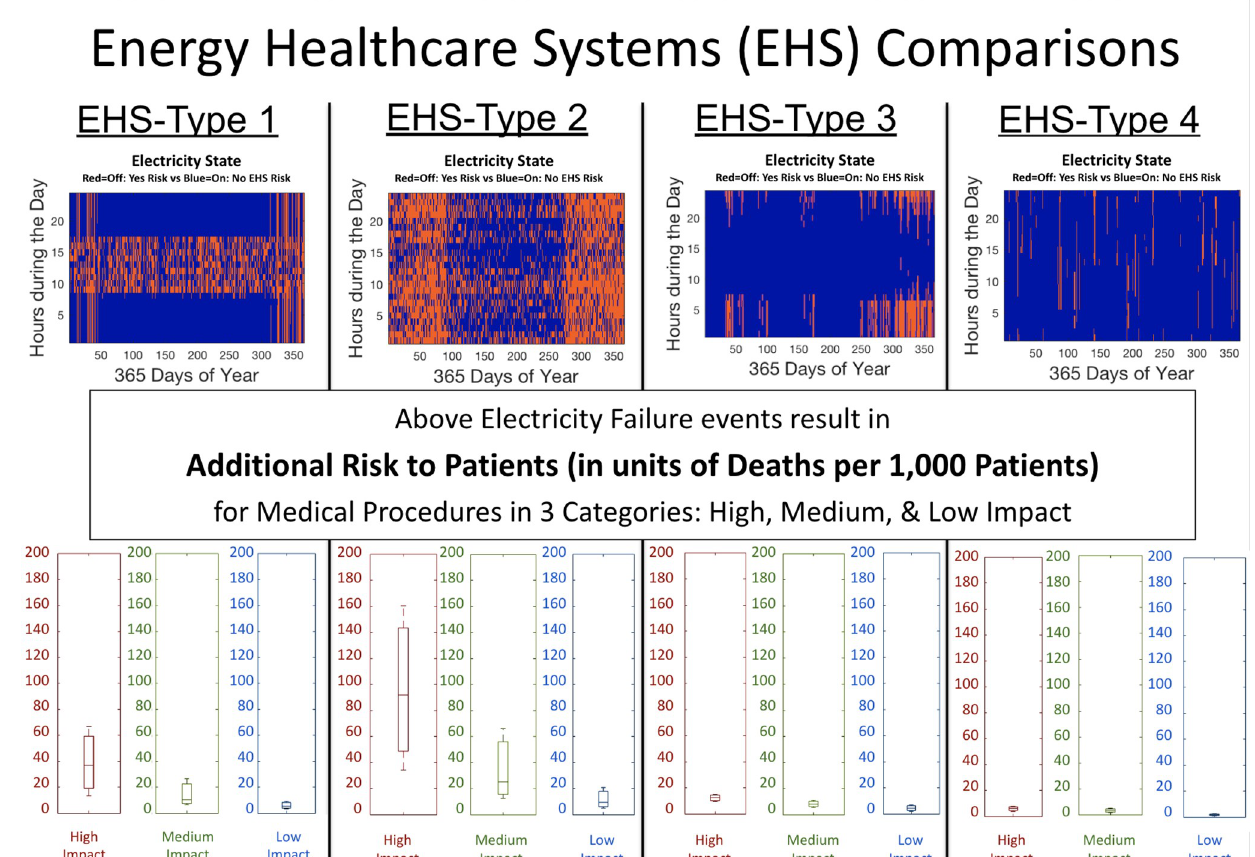
Fig 4. Top figures show four health care electricity failure events for a year with electricity ON in blue (0) and electricity OFF in red (1). The bottom figures show corresponding calculated deaths per 1,000 patients for the entire year for high impact, medium impact, and low impact medical procedures for each system depending on time and duration of electricity failure. Even with grid and backup diesel generator system at a regional hospital, with only 4% energy and time capacity shortages, there were additional risks to